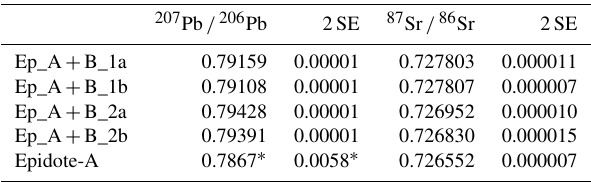
Table 3. Pb and Sr isotope data by solution ICP-MS and TIMS. Uncertainties are 2 standard errors